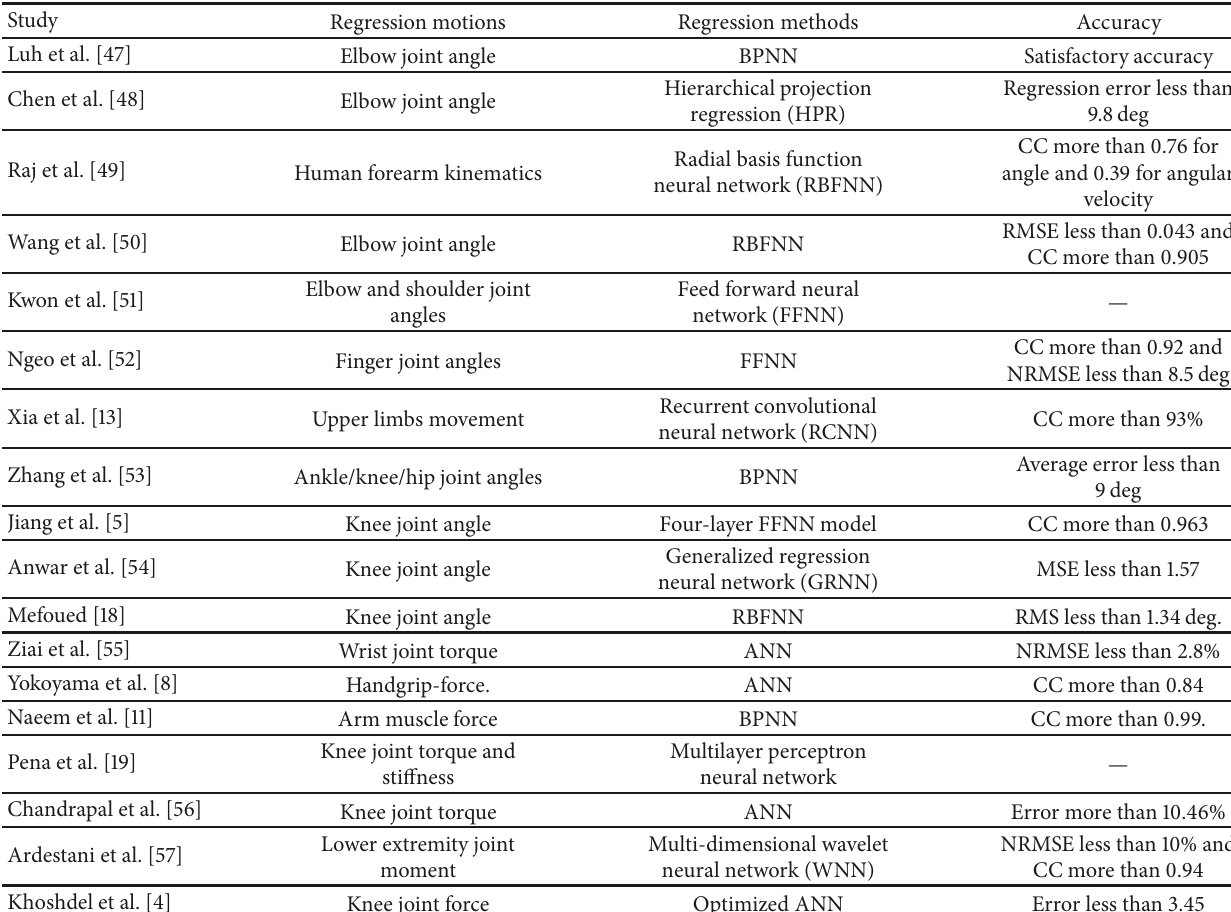
Table 2: Results from most recent studies for continuous-motion